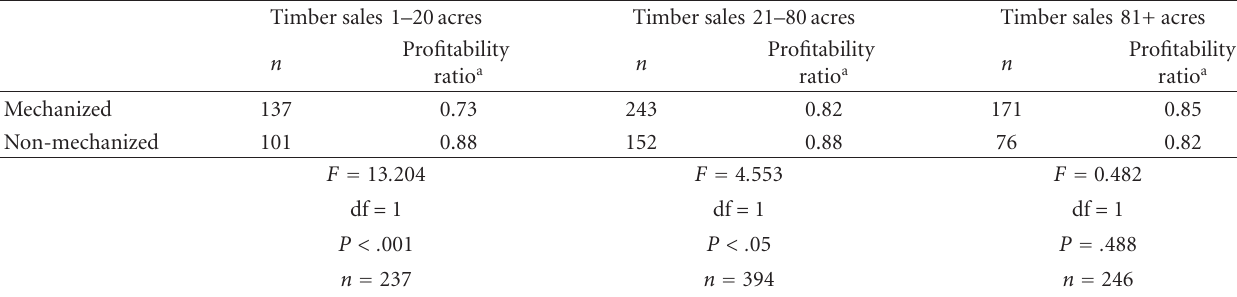
Table 5: Relationship between mechanization and profitability of timber sales of varying